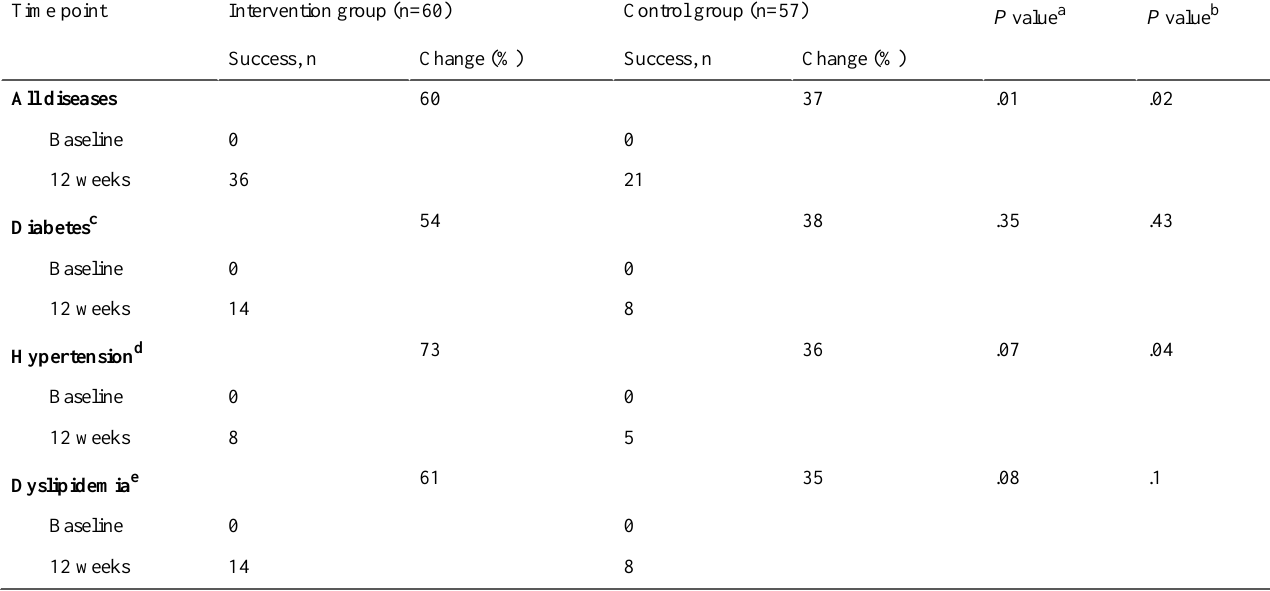
Table 2. Differences in clinical outcomes controlling for the primary disease.